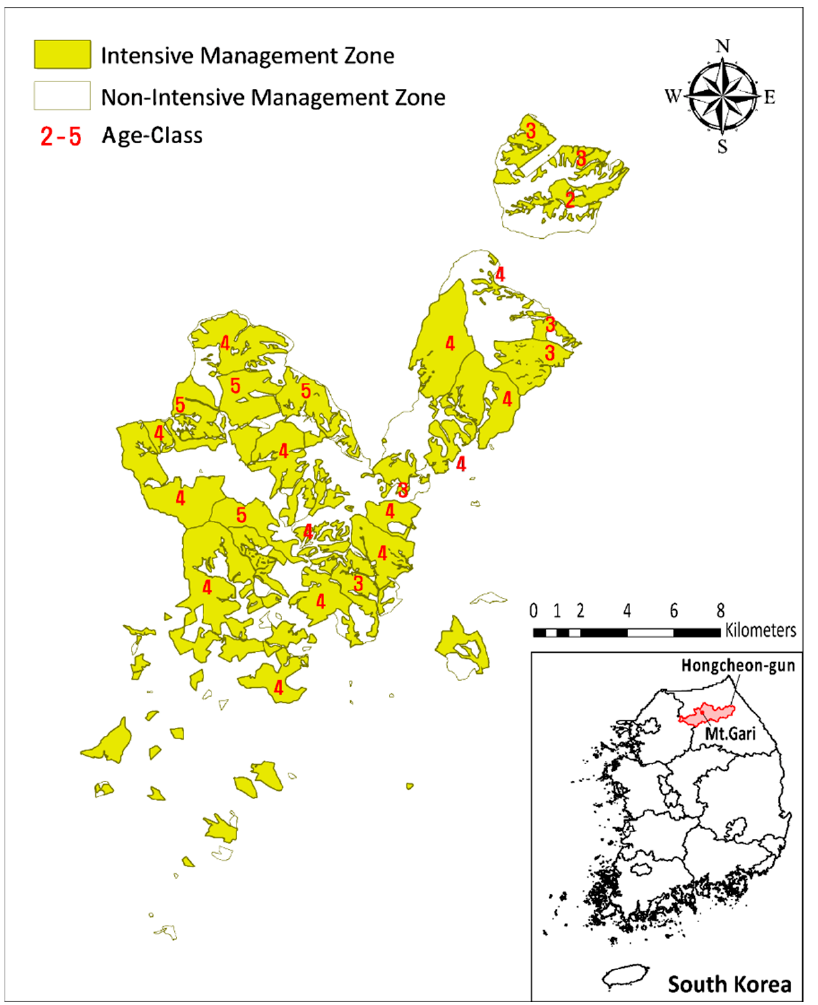
Figure 3. Location of the Mount Gari Leading Forest Management Complex. Yellow shading indicates the intensive management zone and red numbers indicate the forest stand age-class, as detailed in Table 1. Table 1. Age-class distribution of forest stands in the study area [29].